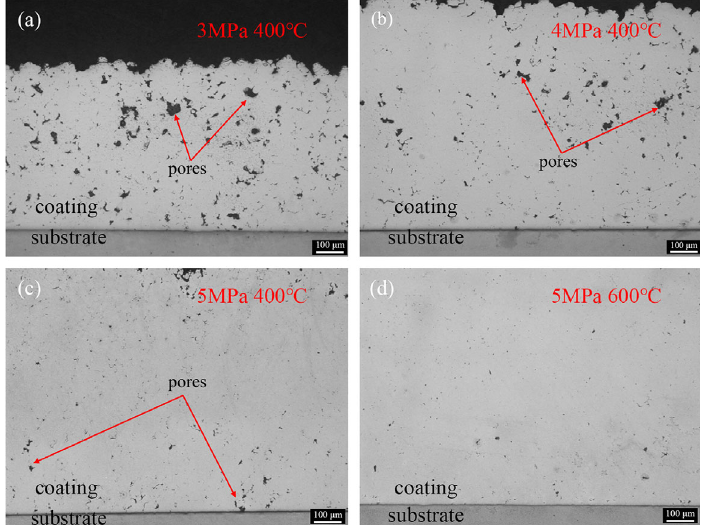
Figure 3. Cross-sectional microstructure of cold-sprayed Al coatings. ( a ) 3 MPa 400 °C; ( b ) 4 MPa 400 °C; ( c ) 5 MPa 400 °C; ( d ) 5 MPa 600